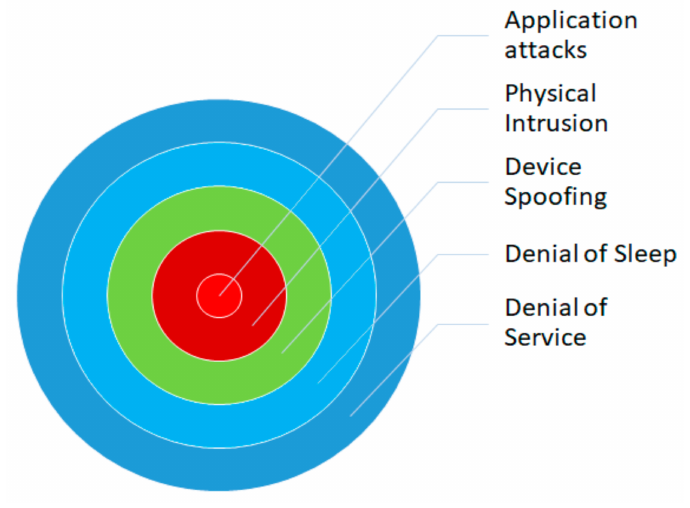
Figure 4. Cyber-attacks in IoT